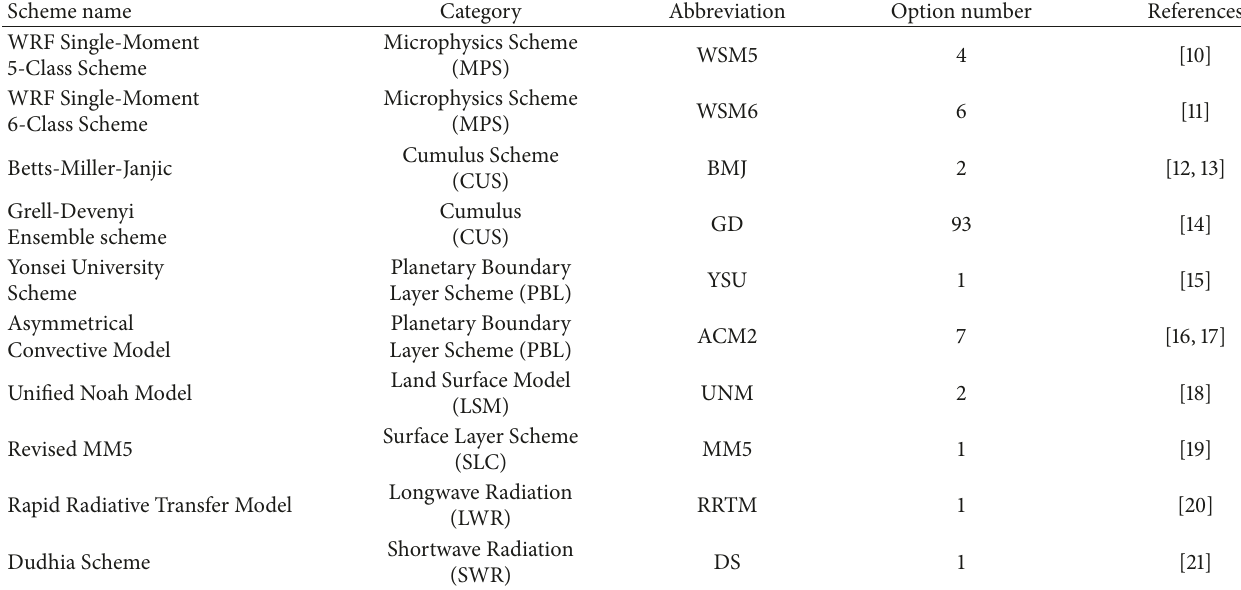
Table 1: Summary of physics parameterization scheme categories and the options used in this study. Two options each from microphysics, cumulusscheme,andplanetaryboundarylayerschemesareused,whileoneoptionfromeachoftheremainingphysicsschemeswasemployed